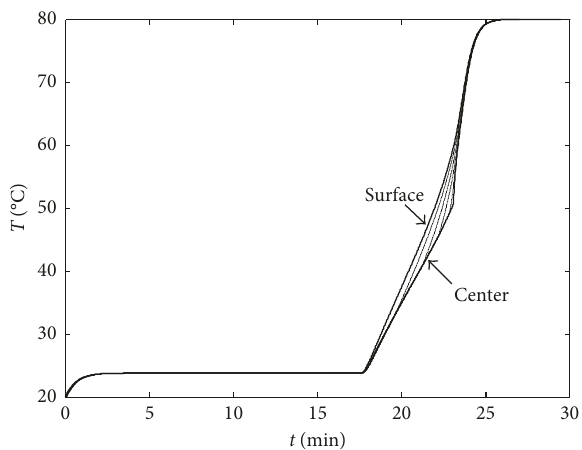
Figure 5: Drying of a sphere of light concrete: temporal evolution of temperature for approximately every 0.5mm in distance.